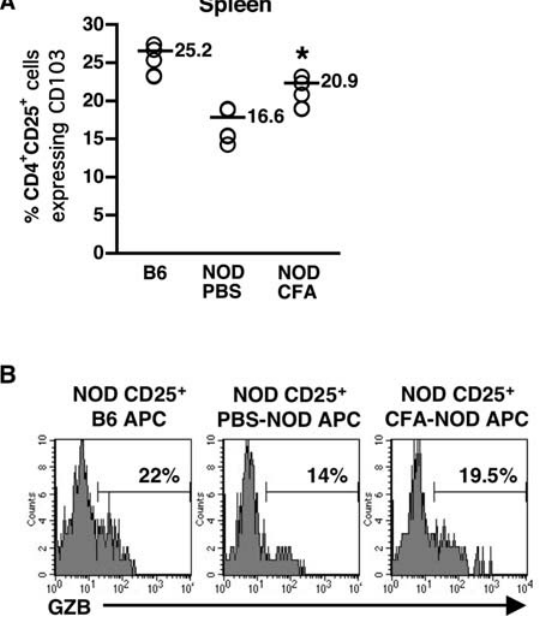
Figure 5. CFA treatment enhances the percentage of CD4 + CD25 + regulatory T cells expressing CD103 and granzyme B. Spleen cells were harvested from 11 week-old B6 or NOD mice injected with PBS or CFA three weeks earlier. Cells were labeled with anti-CD4, CD25 and CD103 antibodies and analyzed by FACS H gating on CD4 + CD25 + cells. Each point represents an individual animal. An * indicates a significant difference from PBS-treated NOD at p , 0.05 (A). CD4 + CD25 + T cells from 11 week-old NOD mice were pooled and cultured for 40 hrs with irradiated T cell-depleted spleen cells (APC) pooled (4–5 mice) from 11 week-old B6 or PBS- (NOD) or CFA-treated NOD (CFA-NOD) and anti-CD3 antibody. Cells were labeled with anti-CD4 and CD25 antibodies, and intracellularly labeled with anti-granzyme B antibody then analyzed by FACS H by gating on CD4 + CD25 + cells. Representative results from one of three experiments are shown (B).